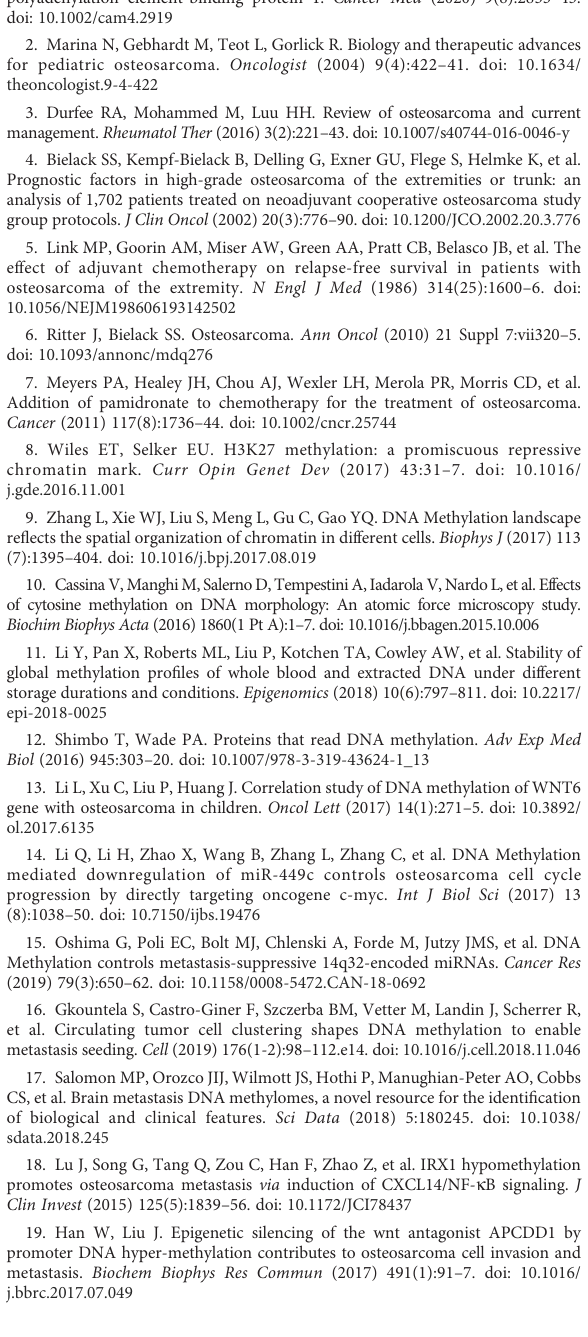
FIGURE S3 The recombinant expression of GFP in 143-B and 143-B-PKIB cells. Representative images to show the GFP channel and DIC channel of 143-B and 143-B-PKIB cells.